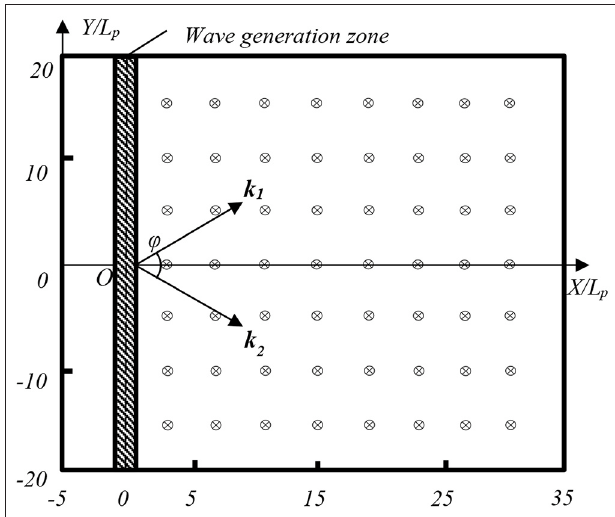
FIGURE 1 | Plan view of the computational domain used in the numerical simulations. : location of wave ⊗